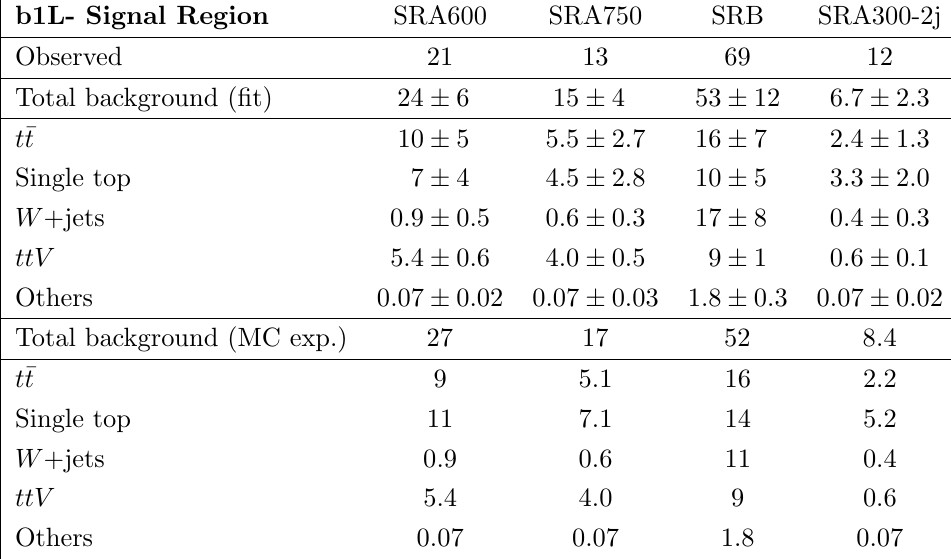
Table 9. Fit results in the b1L signal regions. The background normalization parameters are obtained from the background-only (cid:12)t in the control regions and are applied to the SRs. Smaller backgrounds such as diboson, Z +jets, multijet and rare processes are indicated as \Others". The individual uncertainties, including detector-related and theoretical systematic components, are sym- metrized and can be correlated. They do not necessarily add in quadrature to the total systematic uncertainty.